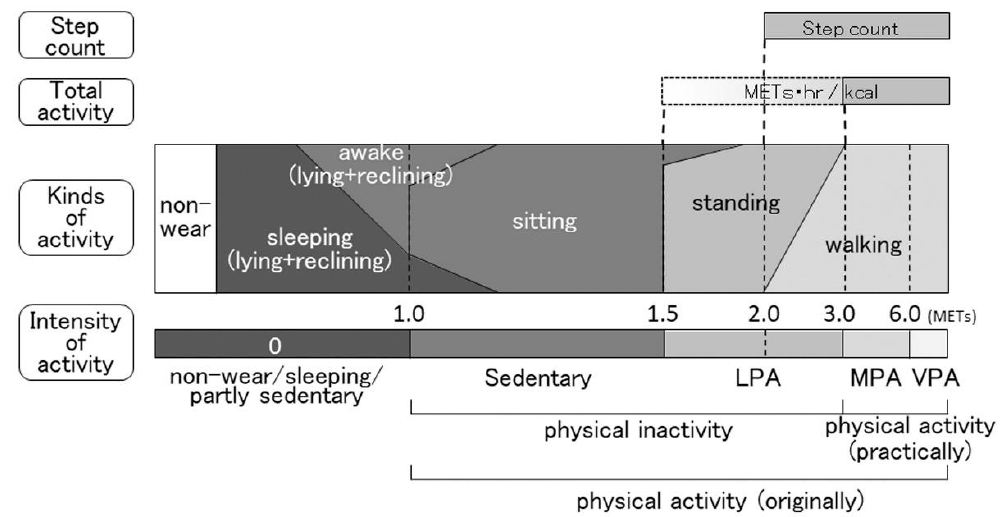
Figure 2. Indicators of physical activity based on the intensity of activity. The kinds of activity do not clearly correspond to the intensity of activity. Abbreviations: METs, metabolic equivalents; LPA, light-intensity physical activity; MPA, moderate-intensity physical activity; VPA, vigorous-intensity physical activity.